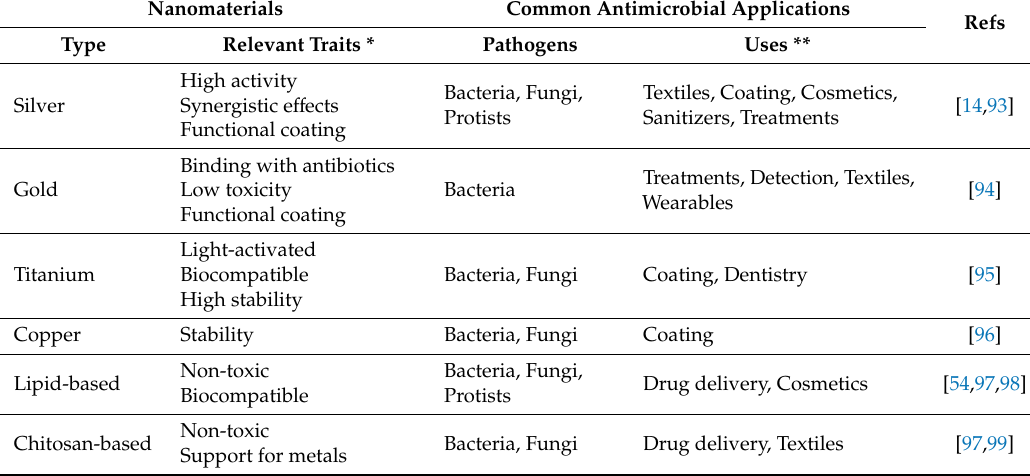
Table 3. Examples of types of nanoantibiotics with current and expected antimicrobial